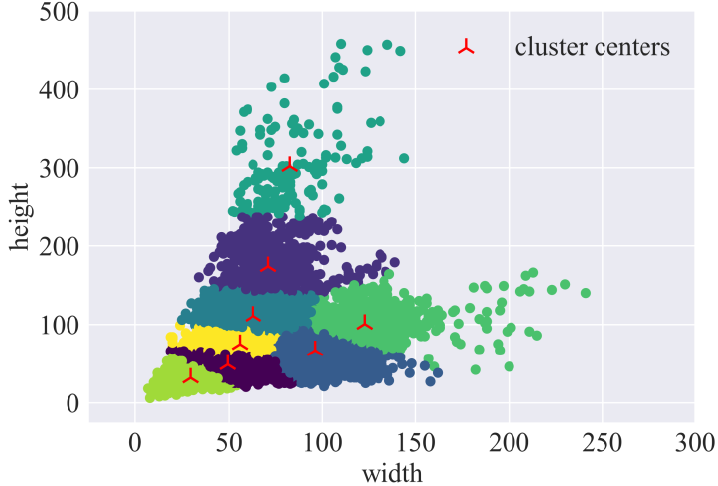
Figure 5. Clustering results of ground truth boxes. The clusters obtained by clustering are distin- guished by different